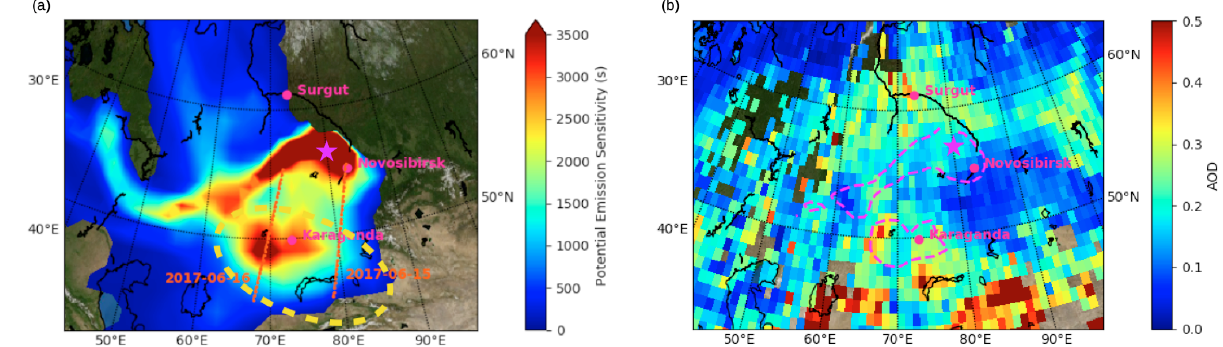
Figure 4. ( a ) Map of the vertically integrated PES distribution in s from a FLEXPART backward simulation for the aerosol layer of Figure 3. Orange dotted lines are the CALIOP nighttime overpasses at 21 UT on 16 June (70 ◦ E) and 15 June (80 ◦ E), 2017. The yellow dotted circle is the dust source area. ( b ) Average of MODIS AOD 550 1 ◦ × 1 ◦ from 13 to 16 June 2017 with PES ≥ 2300 s shown by the pink dotted isoline. The aircraft position is shown by the pink star at 56.6 ◦ N (Map background: NASA’s Earth